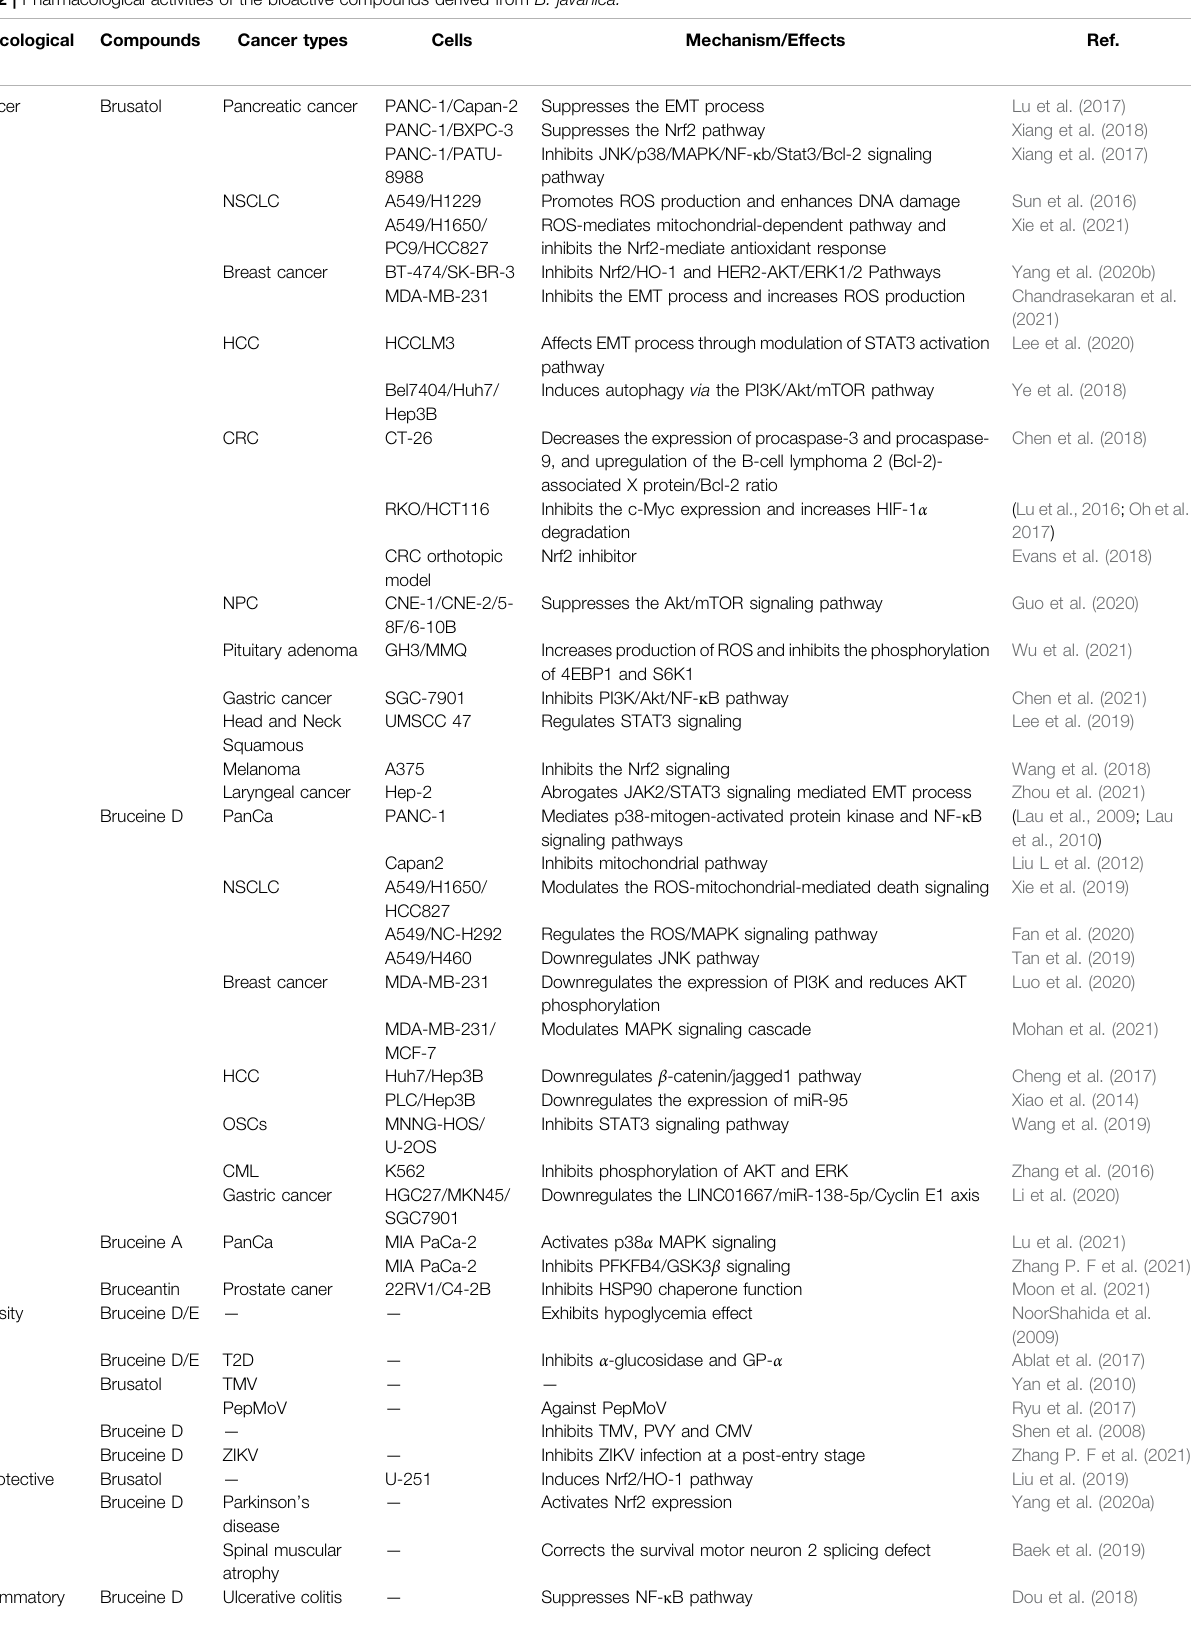
TABLE 2 | Pharmacological activities of the bioactive compounds derived from B.